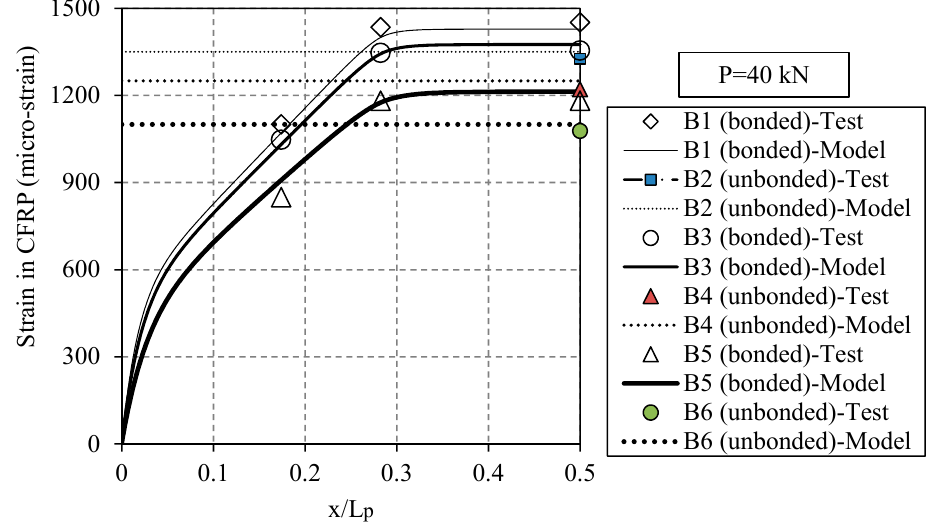
Figure 12. The measured and calculated strains along the bonded and un-bonded CFRP plates for the specimens strengthened with the NM, HM and UHM CFRP plates when the specimen is subjected to an actuator load level of P = 40 kN.